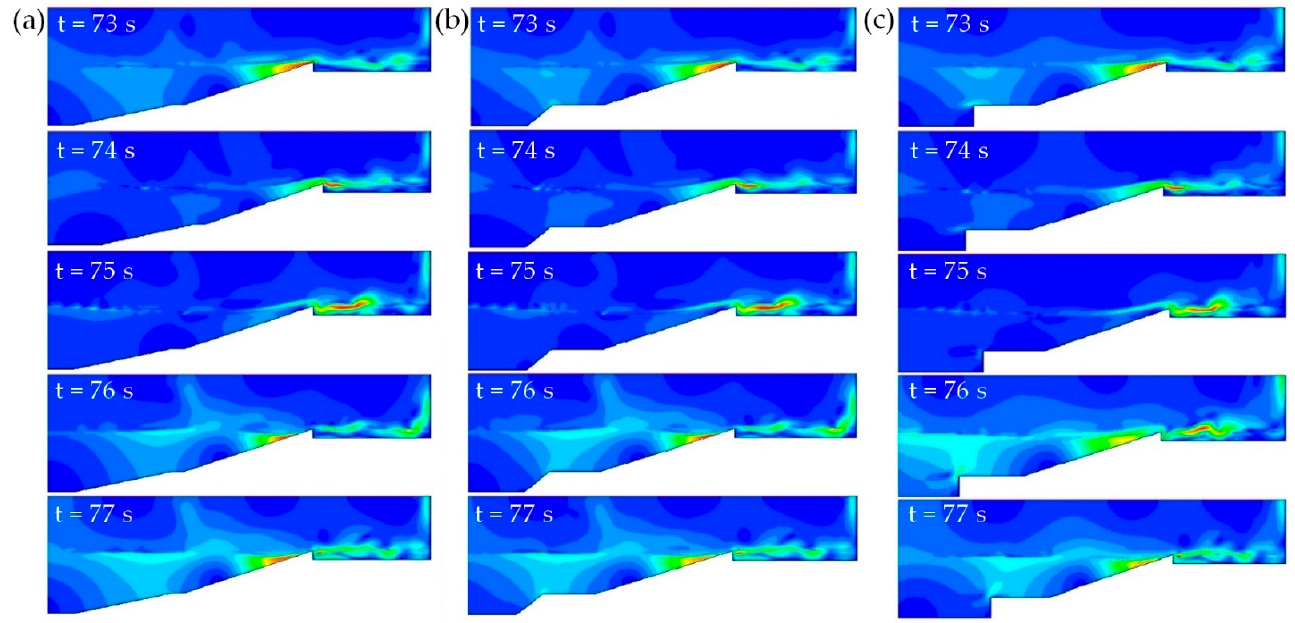
Figure 10. Transient fields of volume fraction for ( H 3 / L 3 ) o = 0.33 and the ratios: ( a ) L 1 / L 2 = 0.11; ( b ) ( L 1 / L 2 ) o = 0.67; and ( c ) L 1 / L 2 = 1.00.